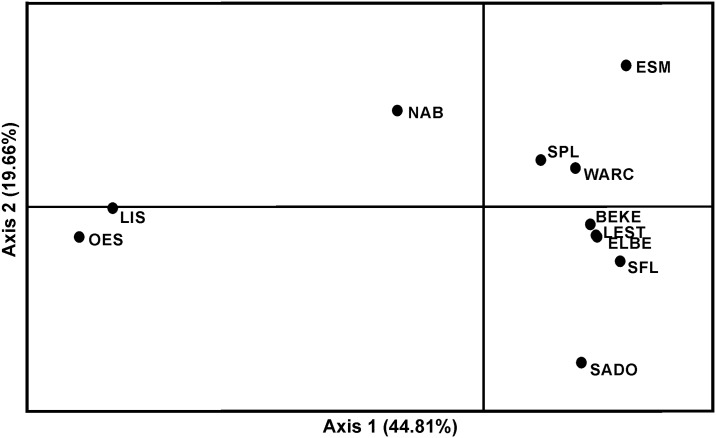
Principal coordinates analysis plot (PCoA) computed by GenAlEx.The percentage of variation explained by each axis is shown. Samples’ acronyms as in Fig 1 and Table 1.